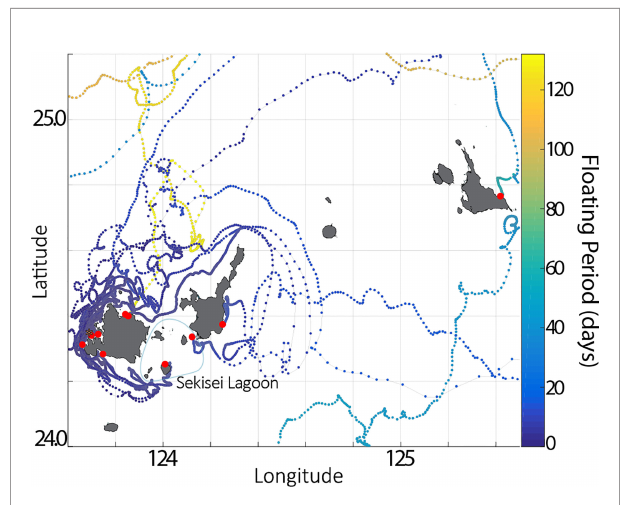
FIGURE 8 | 9 buoys beached within the Sakishima region, one of which drifted for over 100 days while others beached < 60 days, identifying a temporal scale of the trajectories. Deployment site is shown in *, and beaching locations are shown in red. Local beaching events highlighted the absence of trajectories within Sekisei Lagoon, between Iriomote and Ishigaki Islands. Color bars shows temporal data in days for each position of